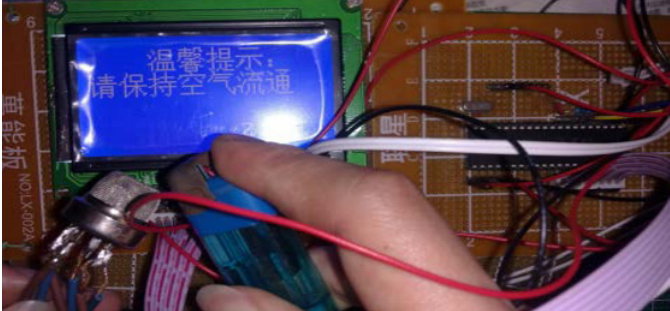
Fig. 3. Oxygen and toxic gas